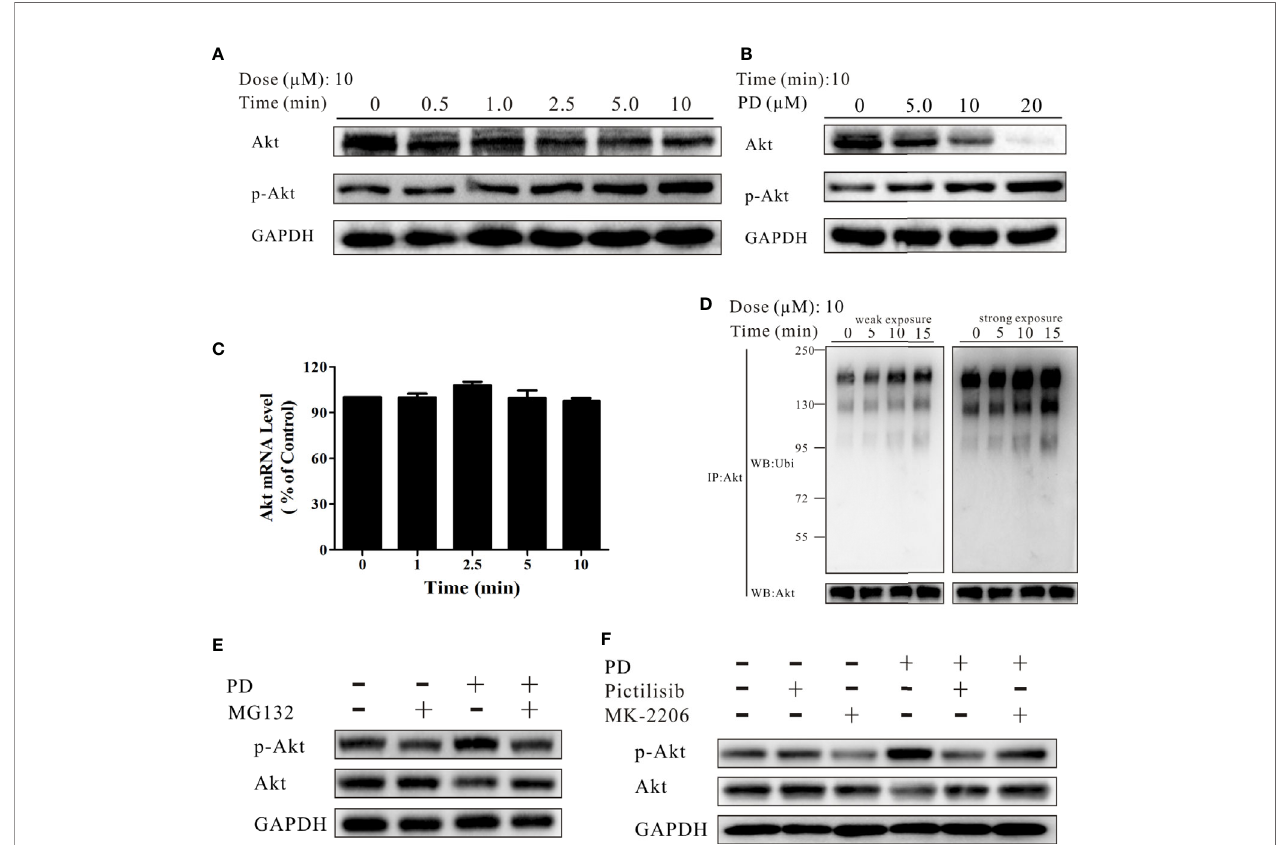
FIGURE 3 | PD promotes Akt ubiquitination. (A, B) The changes in the protein expression levels of Akt and p-Akt induced by PD treatment were time- and concentration-dependent in PC3 cells. (C) The changes in the mRNA expression level of Akt after treatment with 10 m M PD. (D) The changes in ubiquitinated (ubi) Akt in cells following exposure to various concentrations of PD for 10 min after pre-treatment with 10 m M MG132 for 6 h (immunoprecipitation by anti-Akt, followed by Western blotting). (E) The changes in Akt and p-Akt in cells pre-treated with 10 m M MG132 for 6 h prior to exposure to PD for 10 min. (F) The changes in Akt and p-Akt in cells pre-treated with 0.5 m M pictilisib or 1.0 m M MK-2206 for 30 min prior to exposure to PD for 10